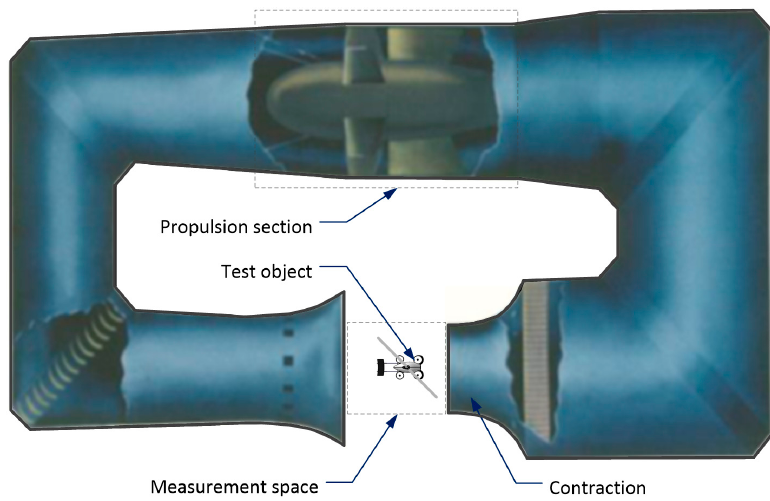
Figure 5. View of the used T-1 wind tunnel at the Polish Institute of Aviation [37].